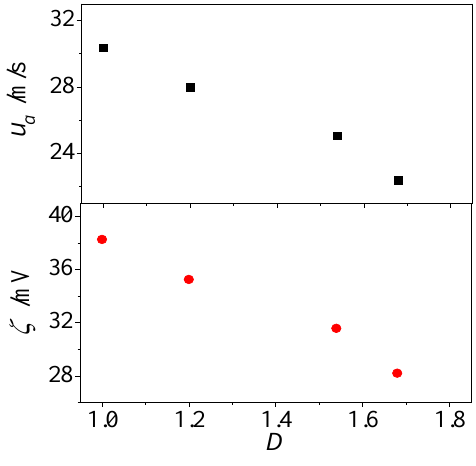
Figure 10. Effect of fractal dimension on electroosmotic flow.